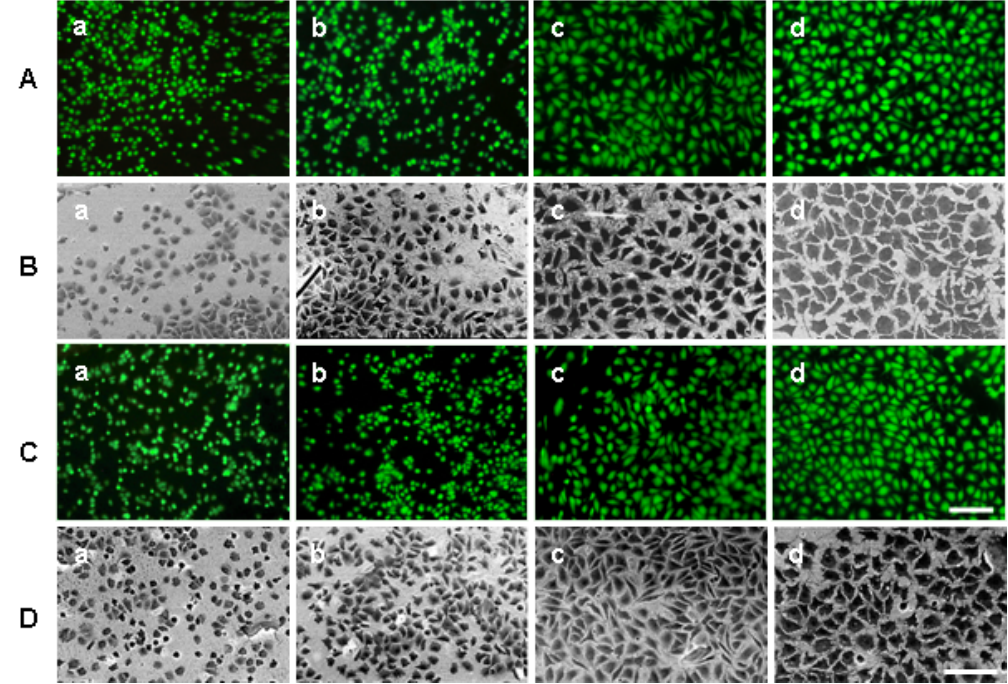
Figure 2. Representative inverted fluorescence (rows A and C) and BSE-microscopic images (rows B and D) of L929 cells after cultivation on the C-surface. The cells were cultured for 2 (a), 4 (b), 8 (c) and 24 (d) hours on C-surface treated with argon-plasma (A and B) or oxygen-plasma (C and D). Scale bars: 100 μ m.